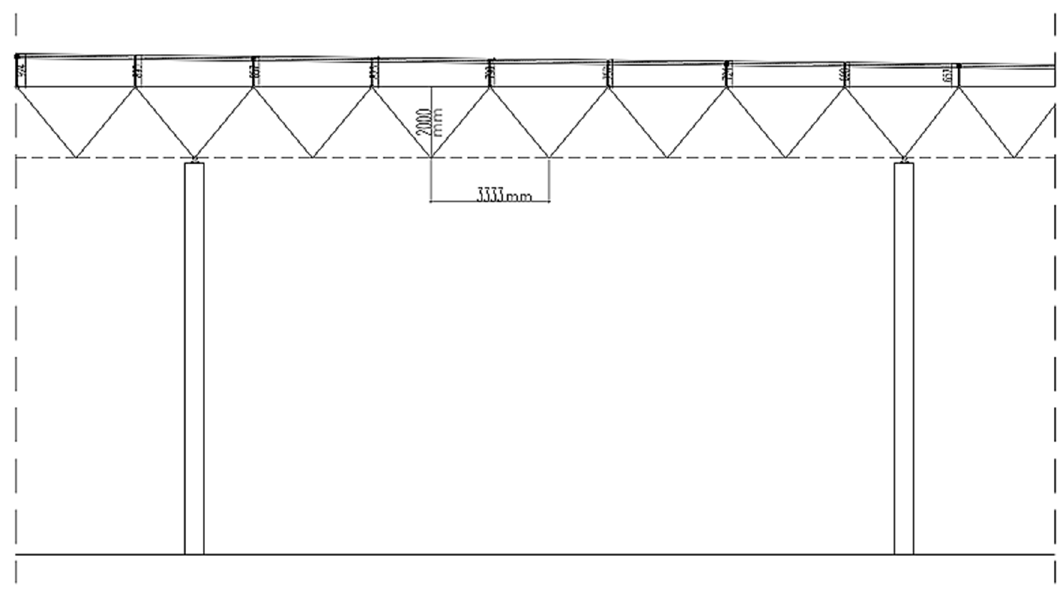
Figure 2. Unit truss structure.